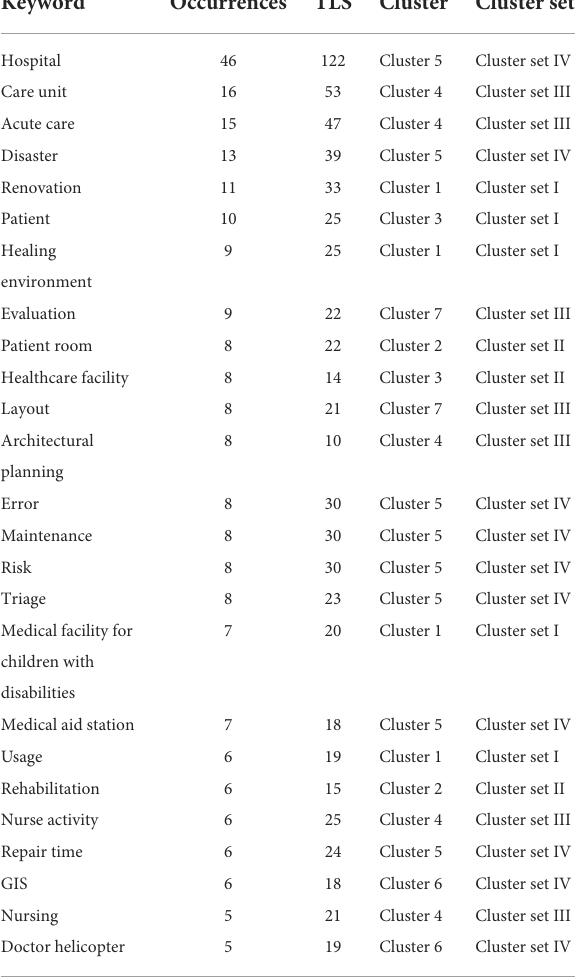
TABLE 4 Top 25 most frequently occurring keywords in the articles selected from AIJ